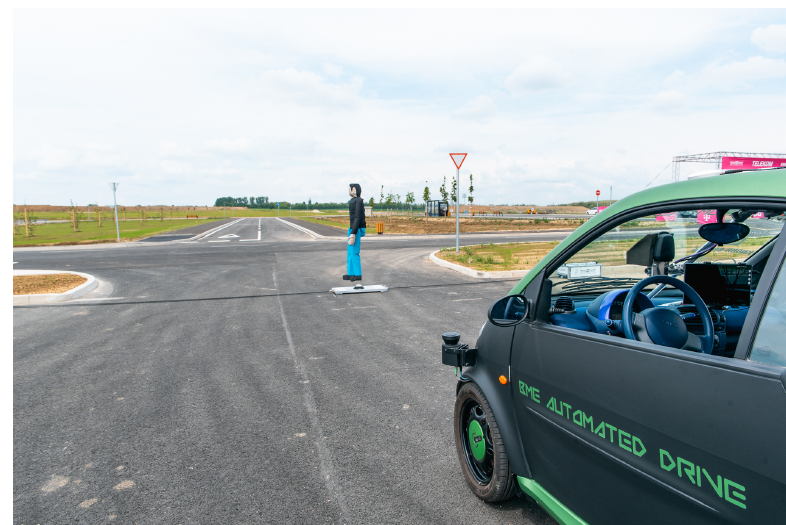
Figure 4. The VUT automatically stops while the 5G controlled dummy “walk” accross the road.